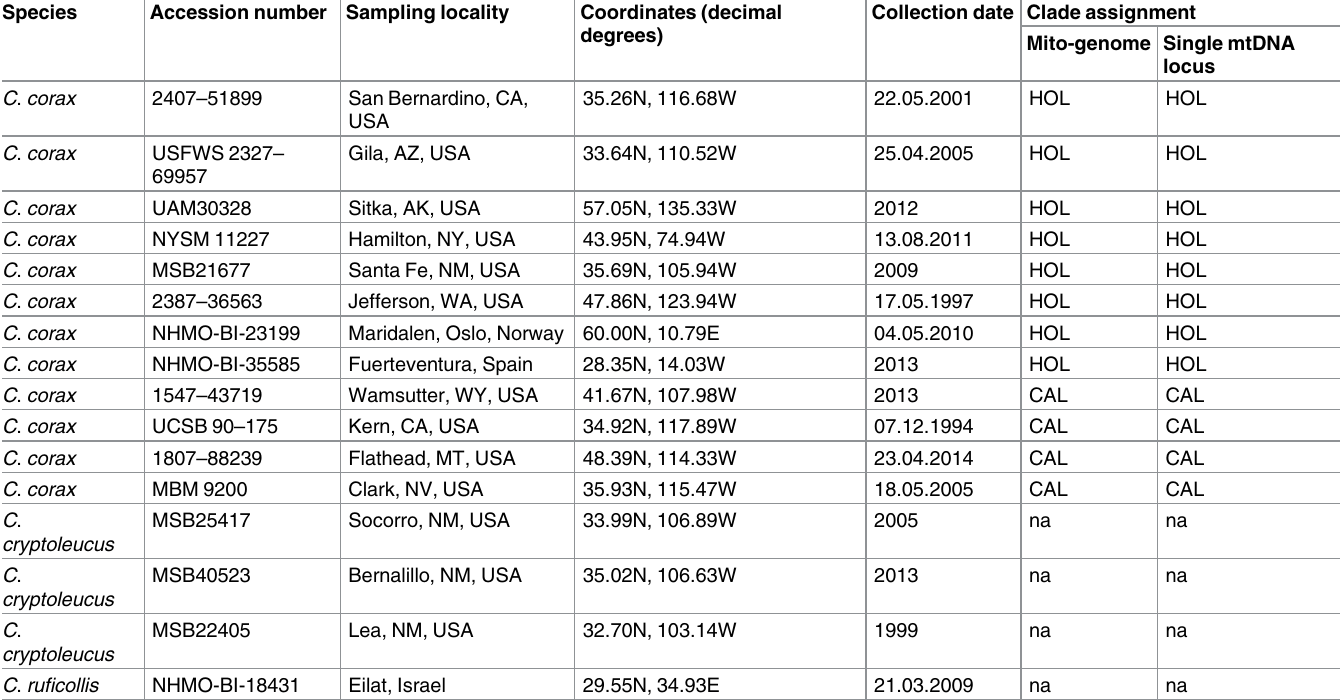
Table 1. Sample information. Cladeassignmentof common ravens from North America to either California or Holarctic lineagesare given for mitogenomes presented in this study and either mtDNA control regionor COI sequencedin previous studies ([17, 18]; authors’unpubl.data). Species